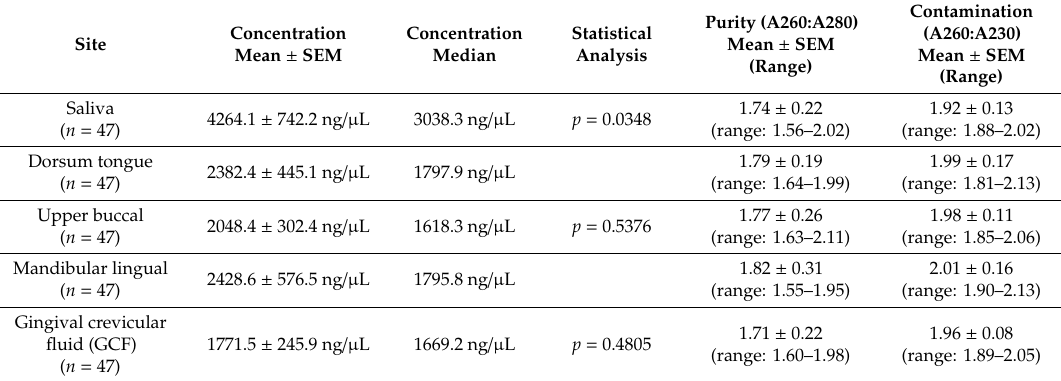
Table 1. Quantitative and qualitative analysis of oral site sampling.